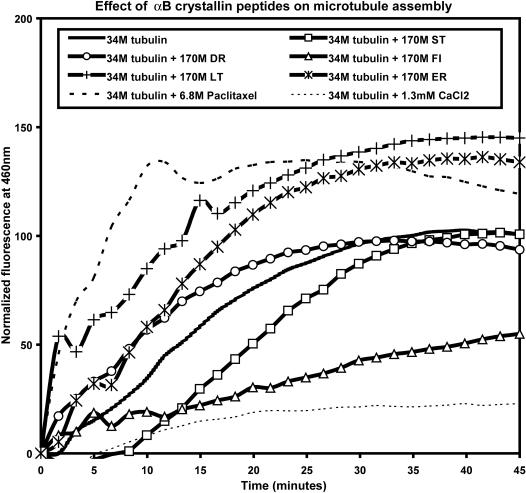
Effect of αB crystallin peptides on microtubule assembly.Samples containing tubulin and αB crystallin peptides or control molecules were excited at λ = 355 nm and the fluorescence emission of DAPI bound to assembled microtubules was recorded at λ = 460 nm. The fluorescence of the sample containing tubulin alone increased rapidly to a maximum value at 45 minutes of incubation at 37°C. The ST (N-terminus) and DR (β3) peptides had no effect on total microtubule assembly, the FI (loop) peptide inhibited microtubule assembly, while the LT (β8) and ER (C-terminus) peptides promoted microtubule assembly. The positive control, Paclitaxel, accelerated microtubule assembly, while the negative control, CaCl2, inhibited microtubule assembly which was consistent with previous reports [59], [60].